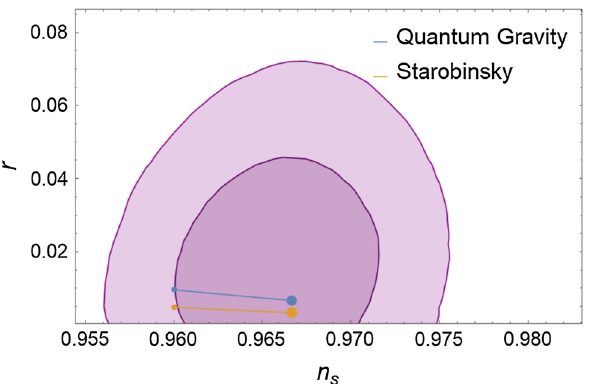
Fig. 2 We plot the tensor-scalar ratio r against the scalar spectral tilt n s for Starobinsky inflation and Effective Quantum Gravity, using (9) and (24), against the 2018 Planck results [17]. The small dot represents N = 50 e-folds and the large dot represents N =